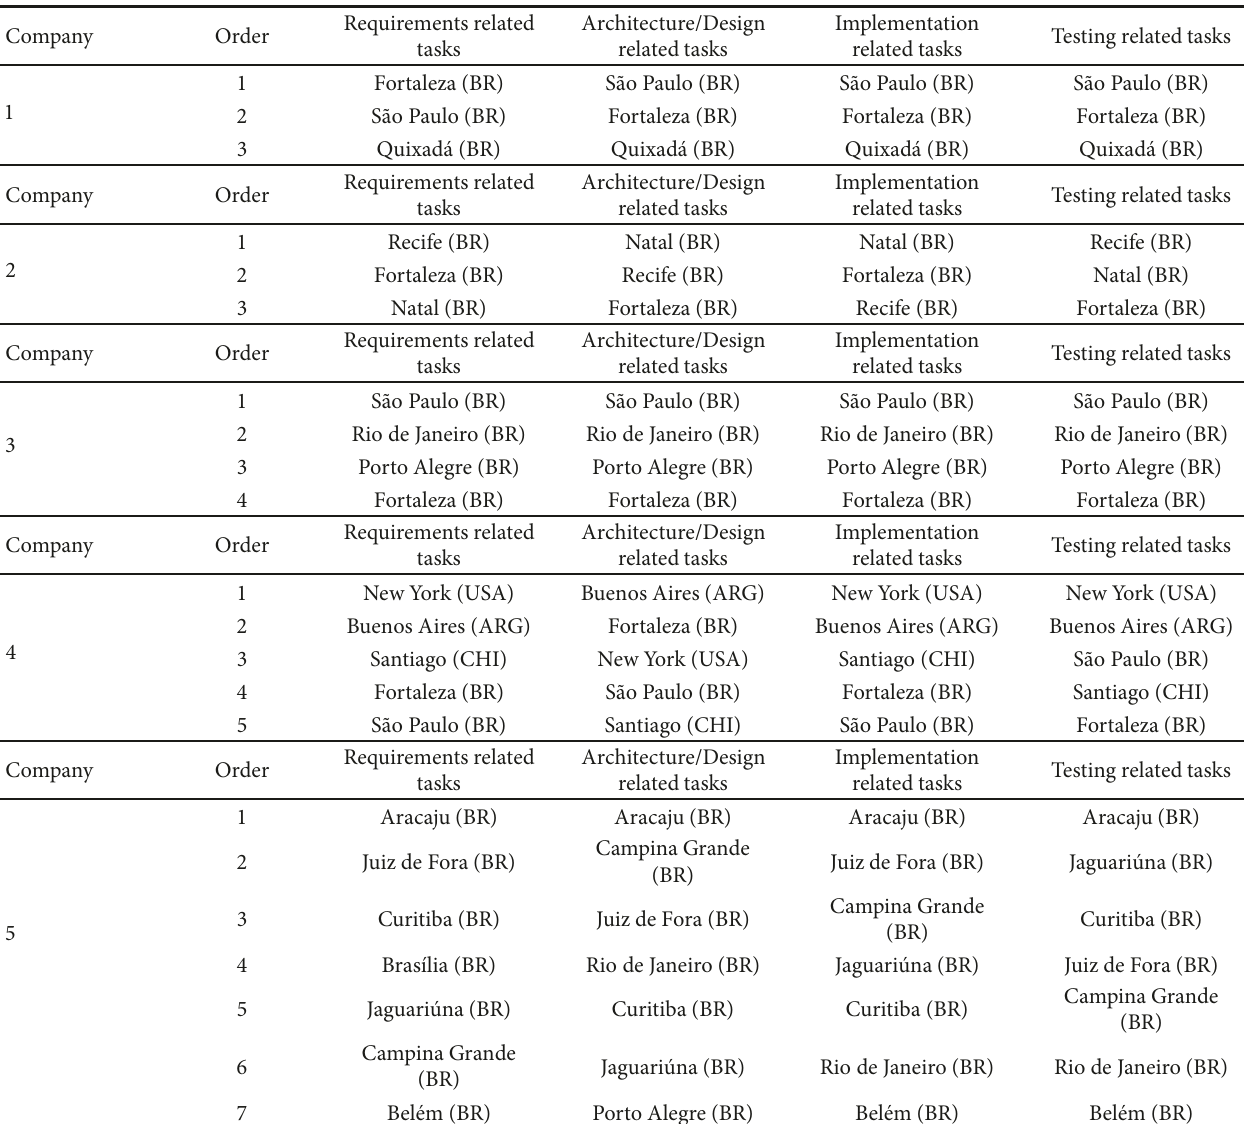
Table 9: Results after applying